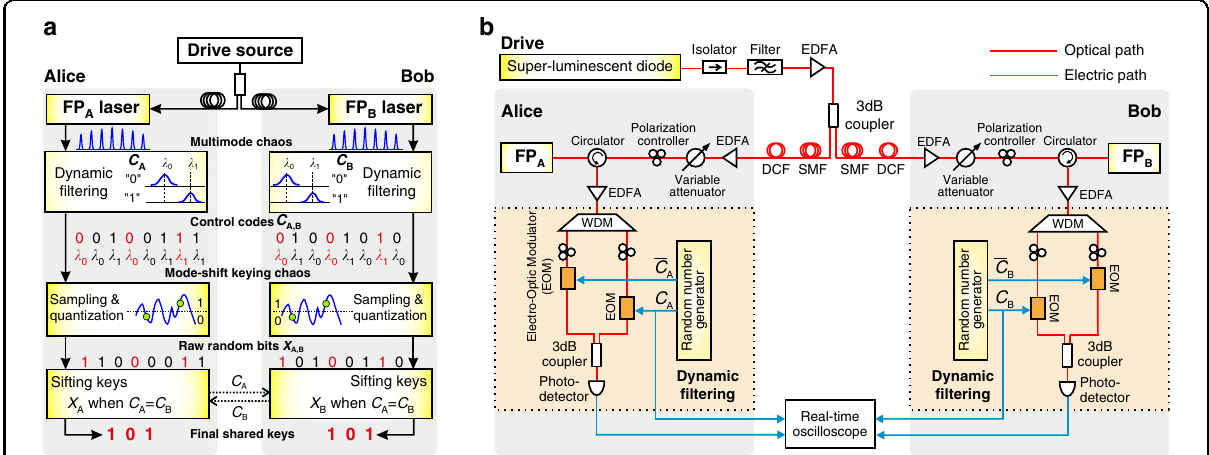
Fig. 1 Overview of the key distribution scheme using mode-shift keying chaos synchronization. a Principle and b experimental system con fi guration. Common-light-driven multi-mode Fabry – Perot (FP) lasers with dynamic fi ltering achieve the mode-shift keying chaos synchronization. The red bits obtained by quantizing synchronized chaos in the mode-matching time intervals are sifted as the fi nal keys. In the experimental con fi guration, dynamic fi ltering consists of a wavelength division multiplexer (WDM) followed by parallel on/off modulation by random binary control codes C A ( C B ) and corresponding inverse